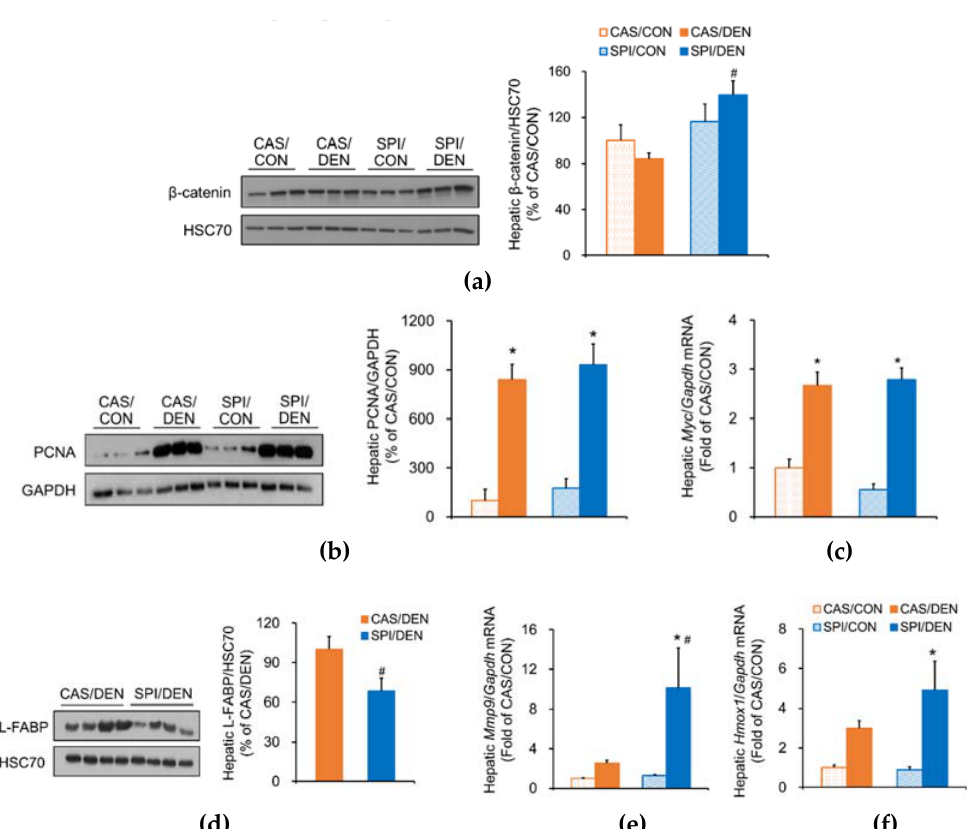
Figure 5. E ff ects of maternal diet on cell proliferation and angiogenesis in the liver of DEN-treated male rat o ff spring. Hepatic protein levels of ( a ) β -catenin, ( b ) proliferating cell nuclear antigen (PCNA), and ( d ) liver type-fatty acid binding protein (L-FABP) were determined by immunoblotting analysis, and were normalized to either heat shock cognate protein 70 (HSC70) or glyceraldehyde 3-phosphate dehydrogenase (GAPDH) protein levels ( β -catenin and PCNA: n = 3 / group, L-FABP: n = 7 or 9 / group). Hepatic microRNA (mRNA) levels of ( c ) Myc , ( e ) Mmp9, and ( f ) Hmox1 were determined by qRT-PCR, and were normalized to Gapdh mRNA levels ( n = 4 − 9 / group). Results are expressed as means ± SEM. * Significantly di ff erent from the maternal diet-matched CON group at p < 0.05. # Significantly di ff erent from the CAS / DEN group at p < 0.05 (by one-way ANOVA with Duncan’s multiple comparison test or by Student’s t -test for L ‐ FABP).